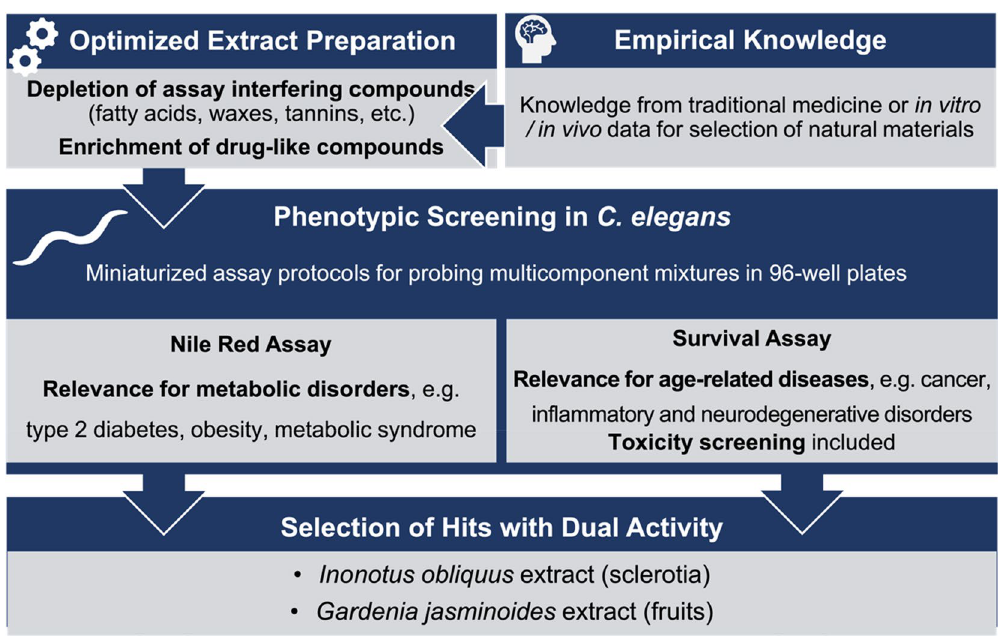
Figure 1. Workflow of the presented